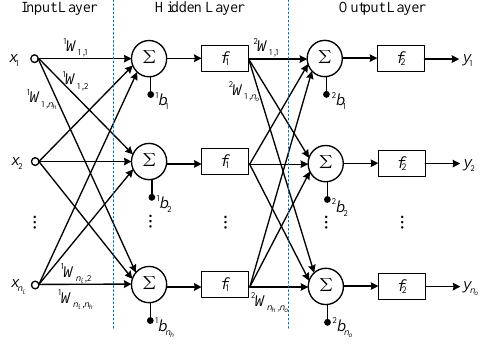
Figure 5. A simple MLP ANN.